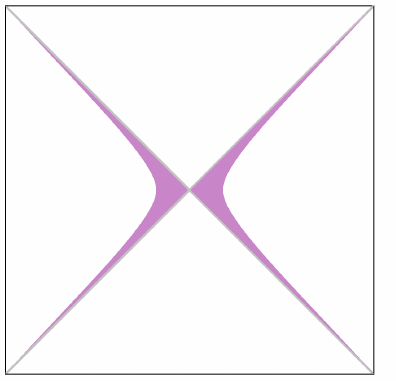
Figure 8. The stretched horizons of the pode and antipode